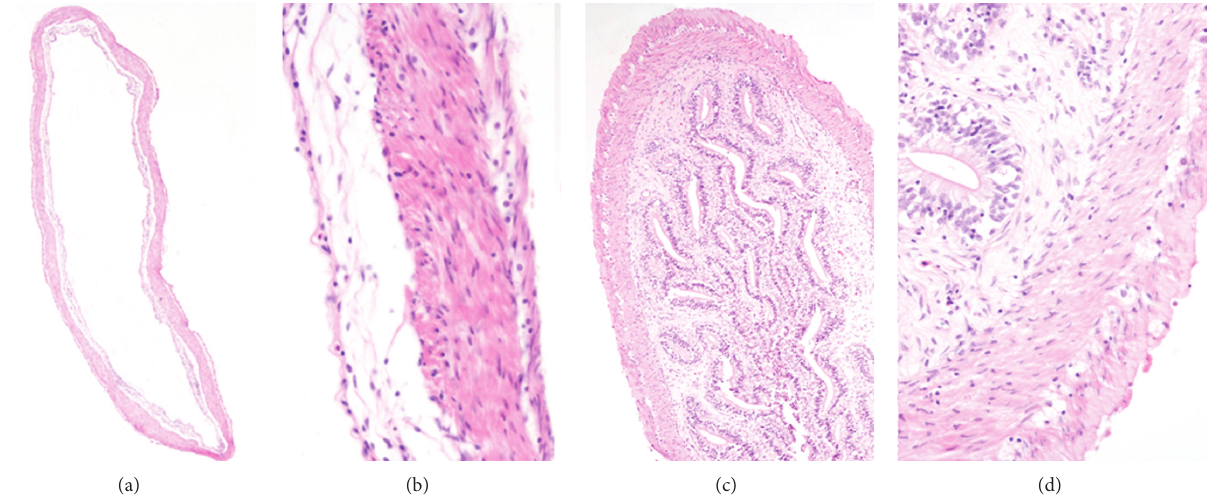
Figure 5: Z. tequila with recurrent abdominal distention: dilated intestinal tract showing complete mucosal and submucosal atrophy with fold disappearance. Moderate thinning of the outer longitudinal layer of the tunica muscularis is also observable ((a)-(b)); adjacent normal intestinal tract ((c)-(d)) (H&E, (a)–(c) 10x, (b)–(d) 40x).